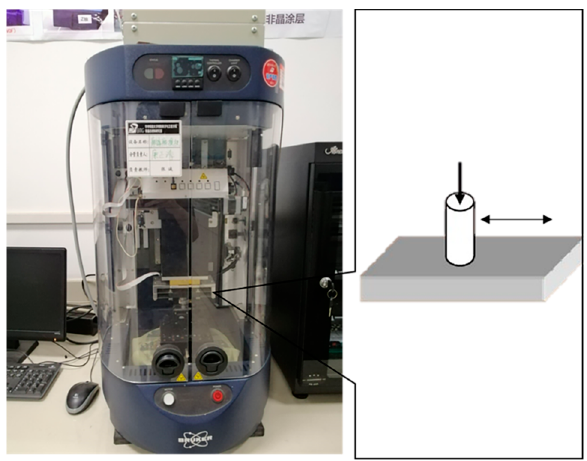
Figure 2. Multi-functional friction and wear testing machine. (UMT-TL).